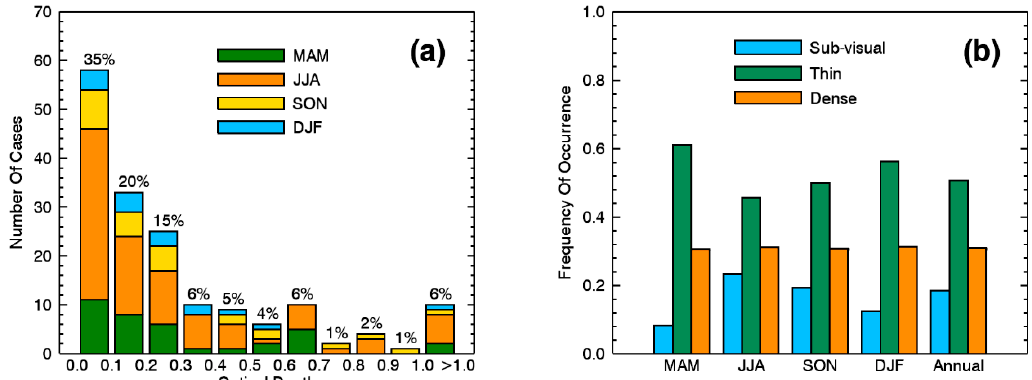
Figure 6. ( a ) Histogram of cirrus optical depth with seasonal proportion, and ( b ) seasonal and annual frequency of occurrence of sub-visual, thin, and dense cirrus clouds. Out of a total of 168 cirrus cloud events, 70% have optical depth values of 0.001–0.3. The occurrence frequency is relatively highest for thin cirrus and lowest for sub-visual cirrus.